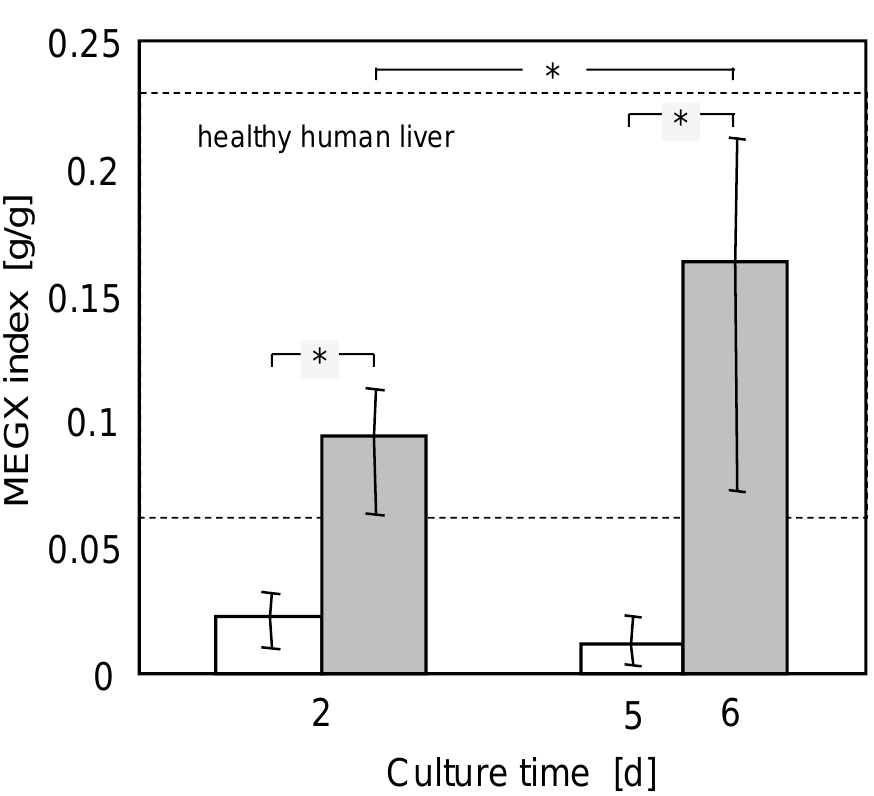
Figure 9. Average MEGX index at various days of culture for cells in adhesion (white bars) or bioreactor (grey bars) culture. Error bars indicate the minimal and maximal values. The shadowed region shows the MEGX index range for healthy human liver. *—statistically significant differences ( p = 0.05).